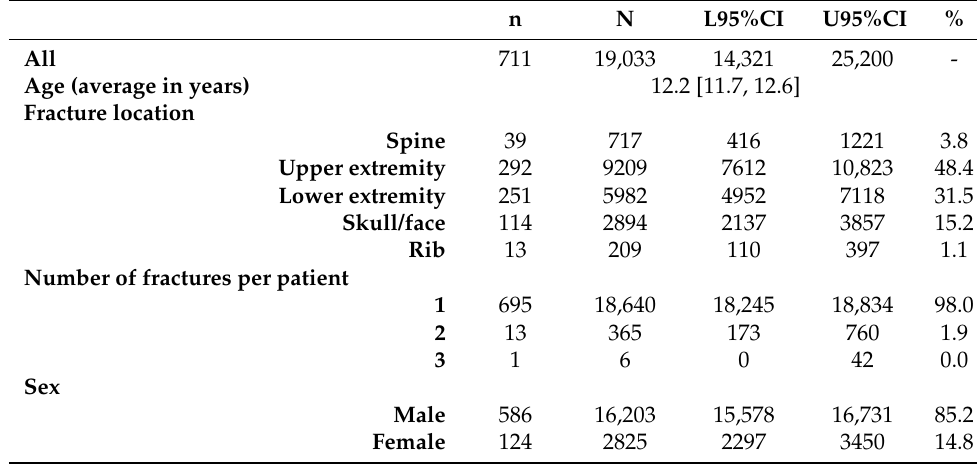
Table 1. Demographics of the 19,033